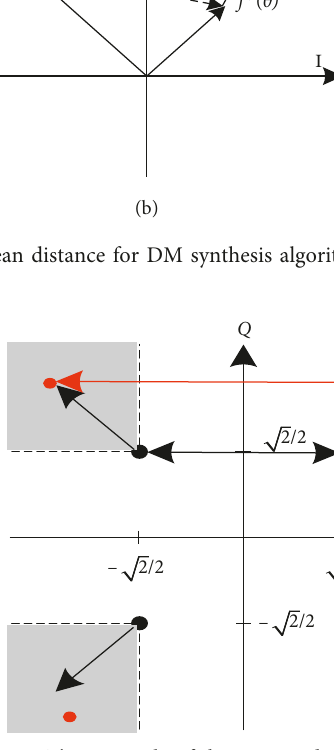
Figure 3: The principle of the proposed ACE method, where the black dots denote the standard QPSK symbols, the red dots denote an example of synthesis symbols based on ACE method, the gray area is the extension area of the proposed ACE method, a black line with arrows at both ends denotes the minimum Euclidean distance of standard QPSK symbols at the desired direction, and a red line with arrows at both ends denotes an example of the minimum Euclidean distance of the proposed ACE